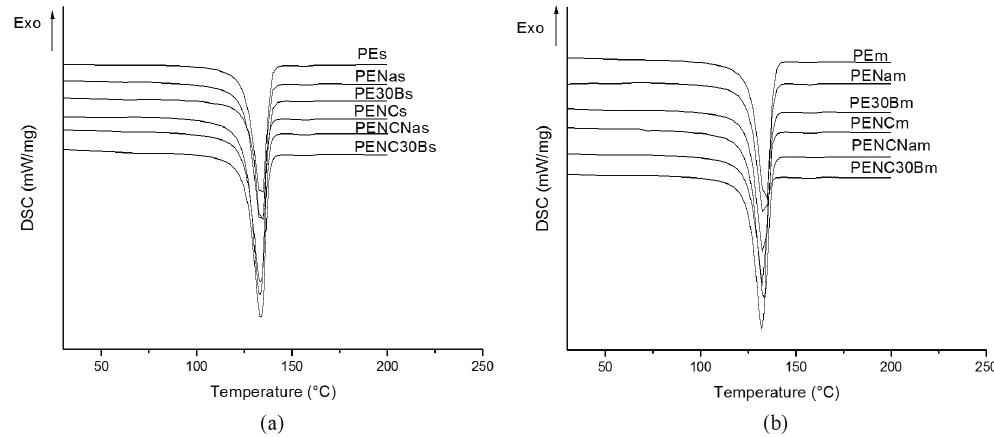
Figure 4. DSC curves for nanocomposites mixing by (a) solution; (b) melting.